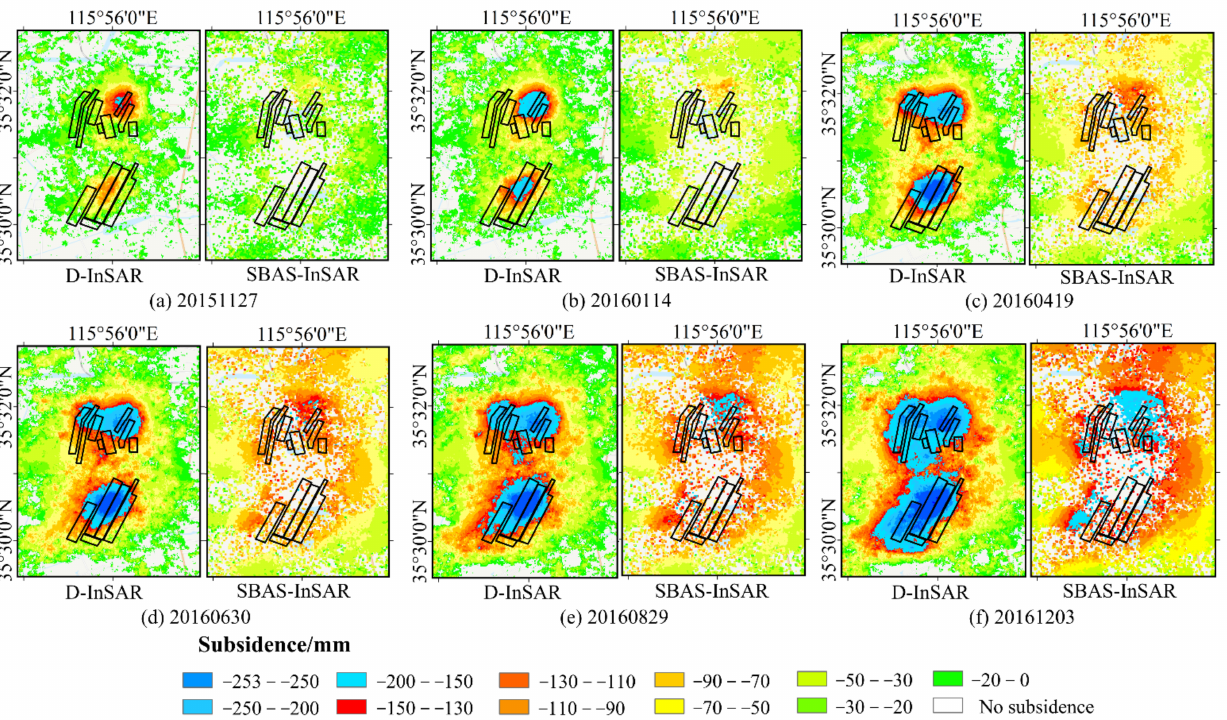
Figure 5. The comparison of D-InSAR and SBAS-InSAR-monitored results during the same